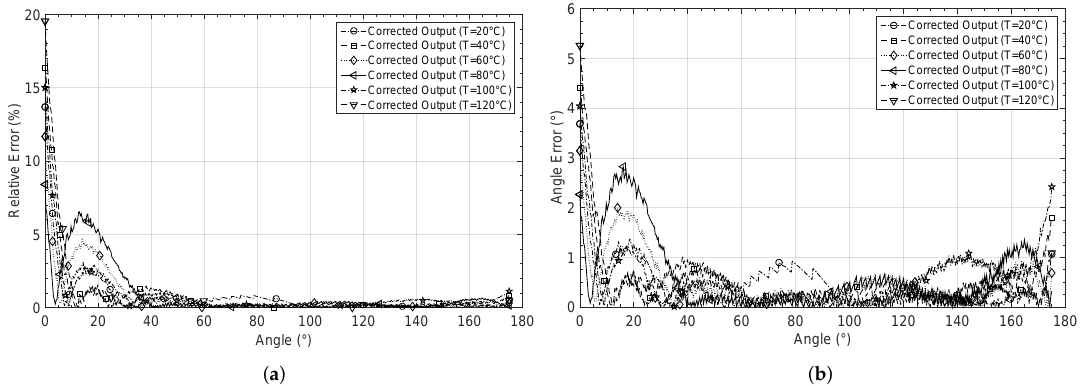
Figure 27. Calculated errors by considering the corrected GMR characteristic at different temperatures: ( a ) relative error e r and ( b ) error in the angle estimation e (cid:93) .